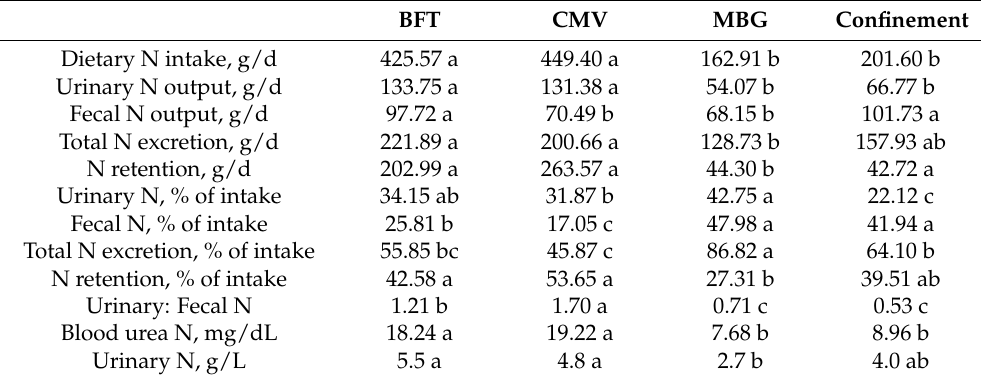
Least squares means (LSMEANS) for each treatment within each year with the same letter are not different at α =